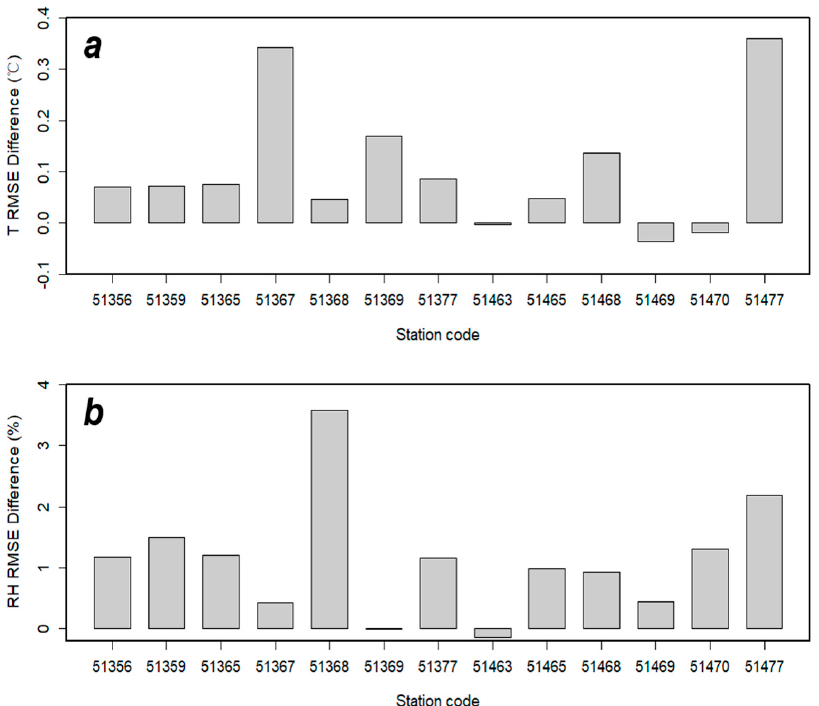
Figure 10. Difference between the RMSE values of post-correction forecasts for: ( a ) temperature and ( b ) relative humidity by AutoML model and moving error post-correction method.